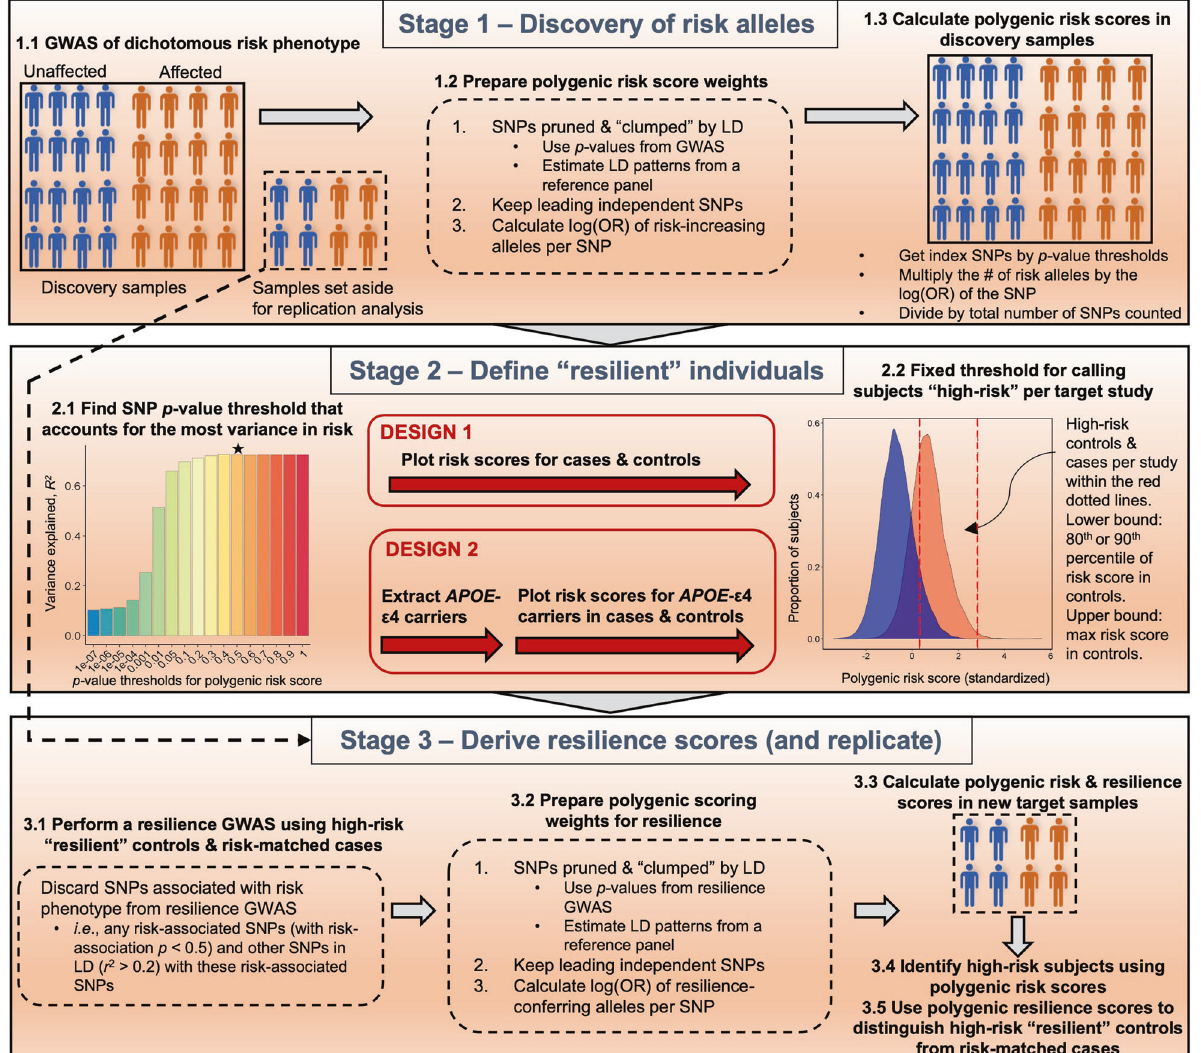
Fig. 1 An illustration of the work fl ow of deriving polygenic resilience scores for late-onset Alzheimer ’ s disease (LOAD) for design 1 and design 2. Stage 1: Using prior LOAD genome-wide association study (GWAS) results to calculate polygenic risk scores (PRSs). Stage 2: Identifying resilient individuals. In stage 2, we deployed two analysis designs differing in the de fi nition of “ resilient ” individuals. In design 1, normal controls with LOAD PRSs ≥ 90th percentile were de fi ned as “ resilient ” participants. In design 2, within the subset of normal controls who had at least one apolipoprotein E ( APOE )- ε 4 allele, a threshold of ≥ 80th percentile of PRSs (excluding SNPs in the APOE region) was used to de fi ne high-risk controls as “ resilient ” . Stage 3: Resilience GWAS and replication of polygenic resilience scores. GWAS was performed using “ resilient ” individuals and risk-matched affected cases from each of the two designs. For each design, polygenic resilience scores were derived and evaluated in external replication datasets. LD linkage disequilibrium, OR odds ratio, SNPs single-nucleotide